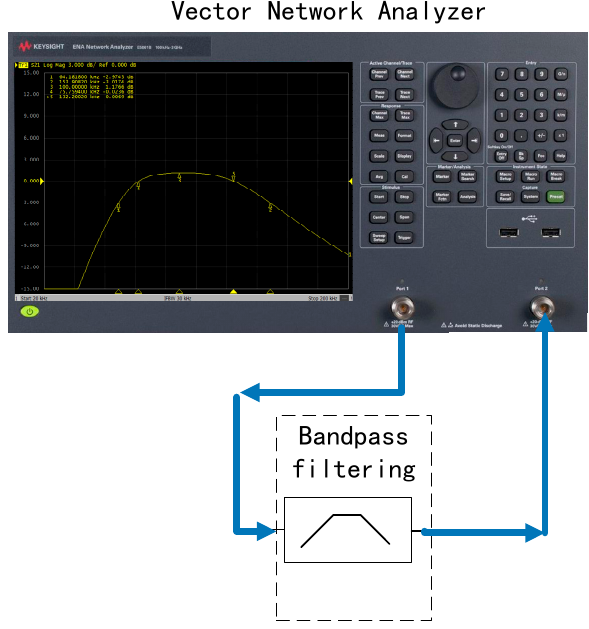
Figure 14. Band ‐ pass filter circuit test connection diagram.